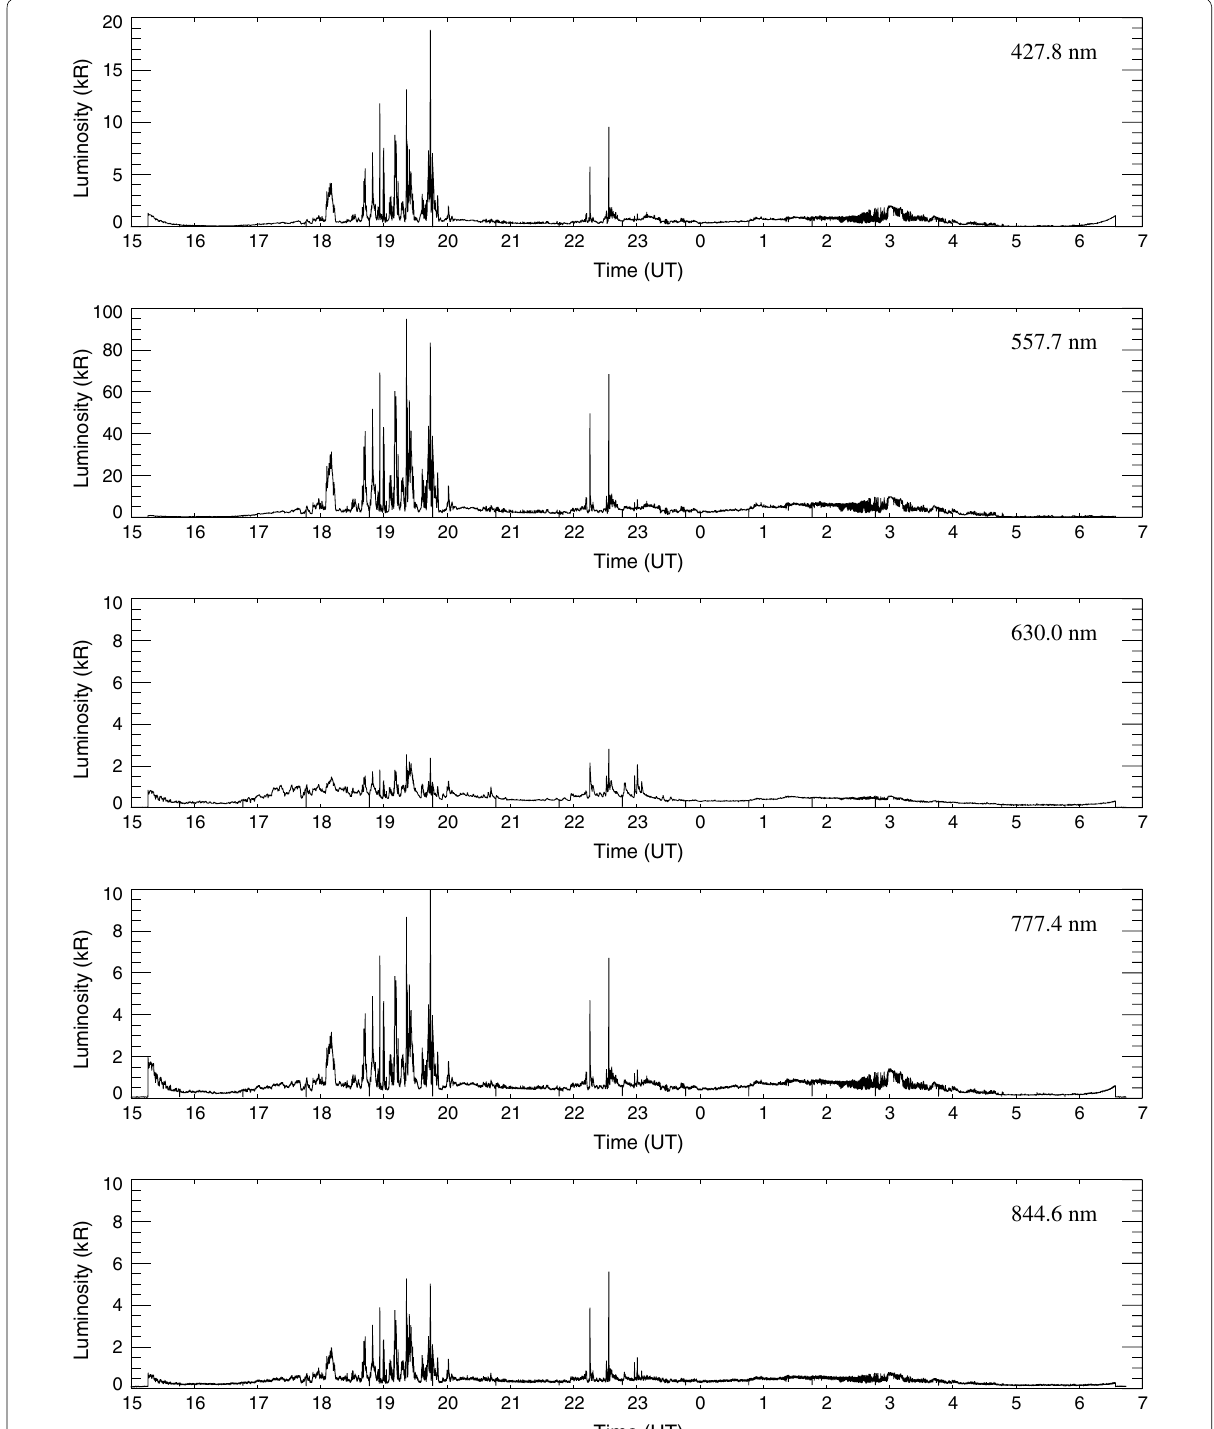
Fig. 13 Temporal variations of the auroral emissions (1 s averaged) obtained with the photometer with five wavelengths between about 15:16 UT on January 22, 2018, and about 06:35 UT on January 23, 2018. The emissions of 427.8 nm, 557.7 nm, 630 nm, 777.4 nm, and 844.6 nm (1 s averaged data) are presented from top to